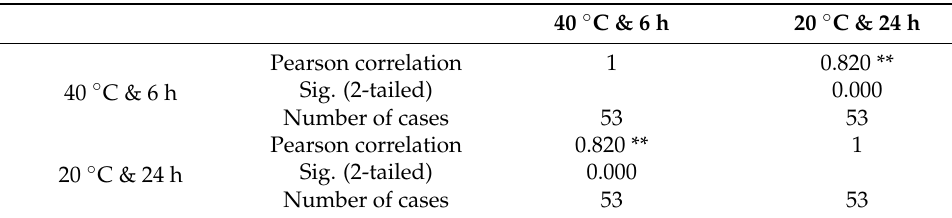
Figure 1. Correlation analysis scatter plot of formaldehyde emissions at 40 °C for 6 h and 20 °C for 24 h. Table 4. Correlation analysis of formaldehyde emissions at 40 °C for 6 h and 20 °C for 24 h.